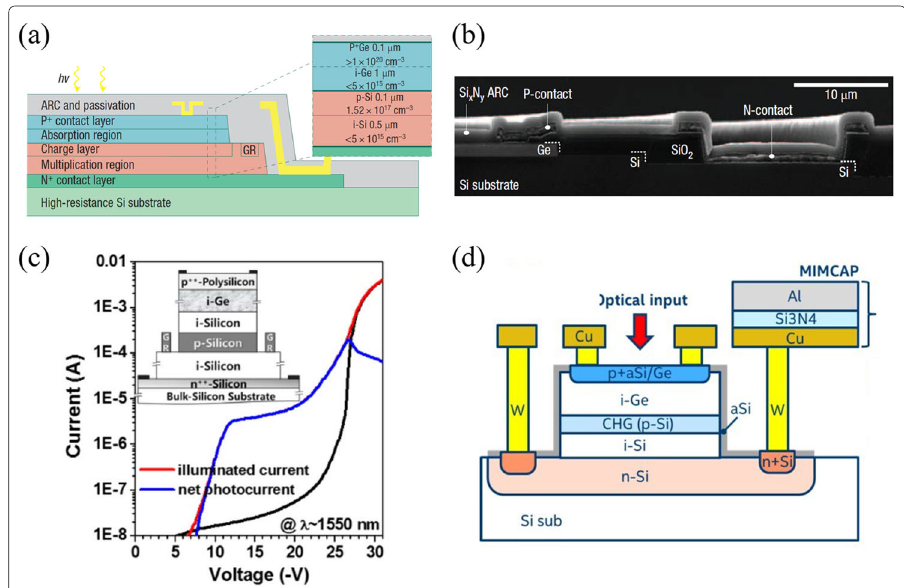
Fig. 4 a Schematic and b SEM cross-sections of the normal incident Si-Ge vertical SACM APD [72]; c Measured I-V characteristics of the negative differential resistance NI Si-Ge SACM APD. Inset is the